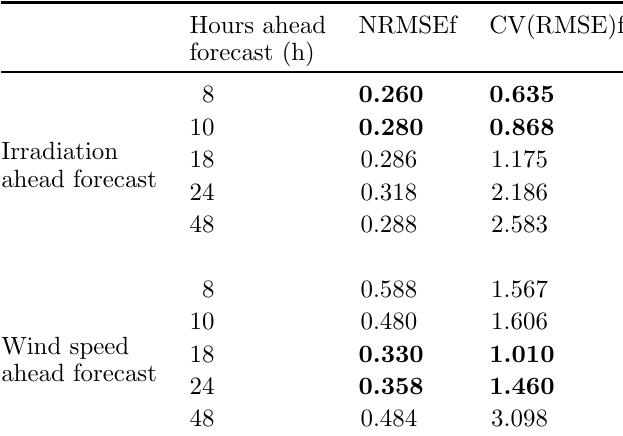
Table 1. Performance indices for the NARX in forecast- ing (bold values represent the best